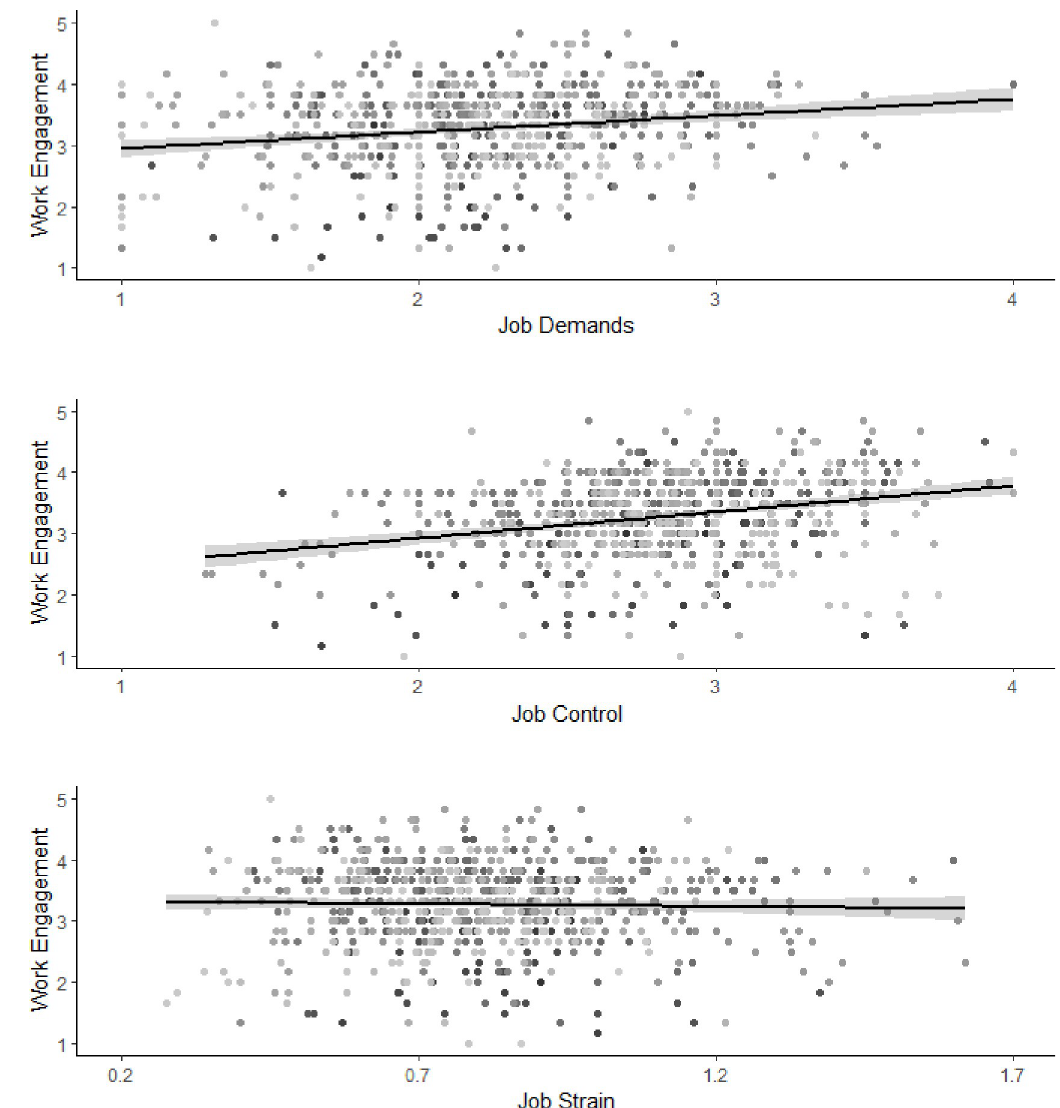
Fig 1. Crude associations of job demands, job control, and job strain with work engagement. For job demands and job control, items were answered on a 4-point Likert scale ranging from “I strongly disagree” (1) to “I strongly agree” (4). The demand/control ratio was calculated by dividing the daily means of job demands by the daily means of job control. For work engagement, items were answered on a 5-point Likert scale ranging from “Not at all” (1) to “All the time” (5).